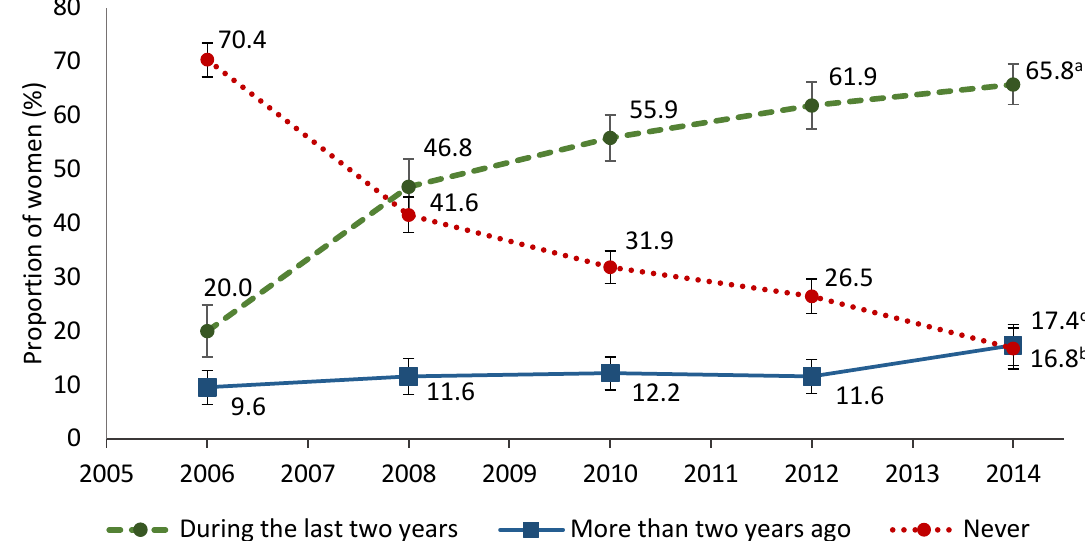
Figure 1. Trends in attendance and nonattendance for mammography screening in 2006–2014. Linear trend: a β = 10.7, p = 0.025; b β = − 12.1, p = 0.017; c β = 1.4, p = 0.066.